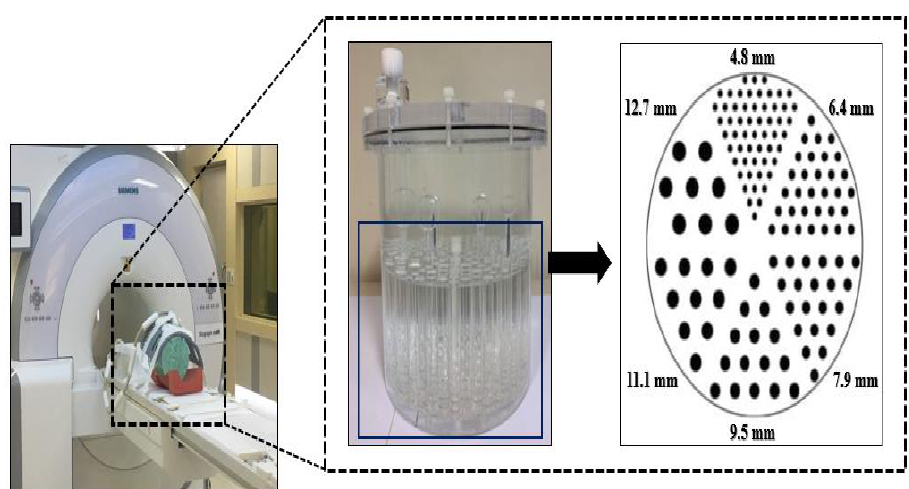
Figure 1. Experimental setup using a positron emission tomography (PET)/magnetic resonance (MR) scanner and a Jaszczak phantom.